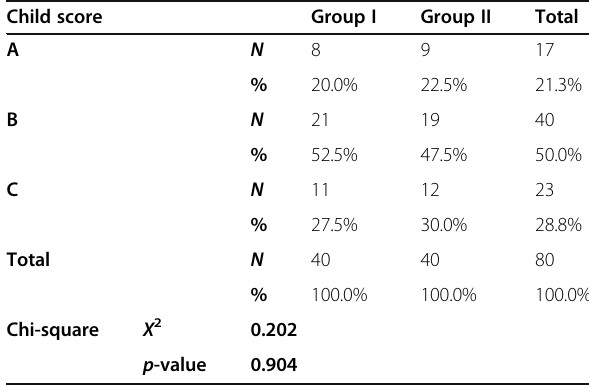
Table 2 Comparison of the Child-Pugh score classification of the studied